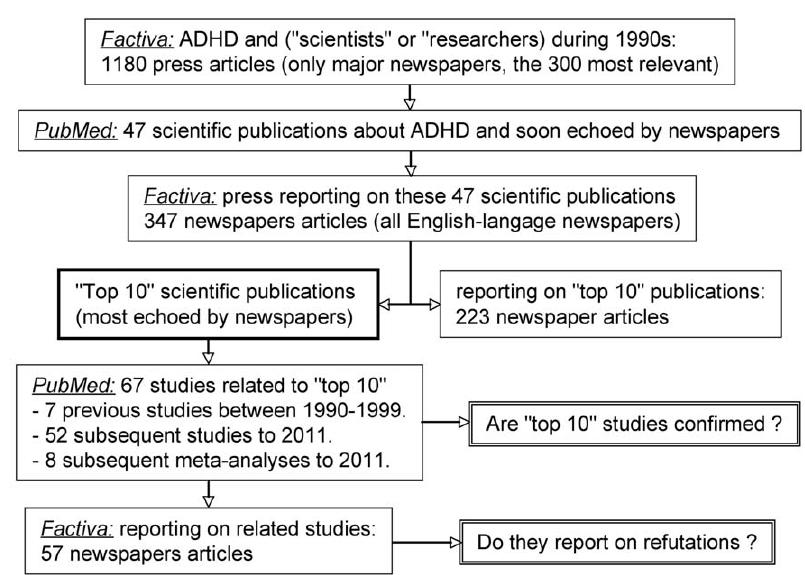
Figure 1. Design of the study. The databases used in each step are indicated in italic . Details are given in the methods.